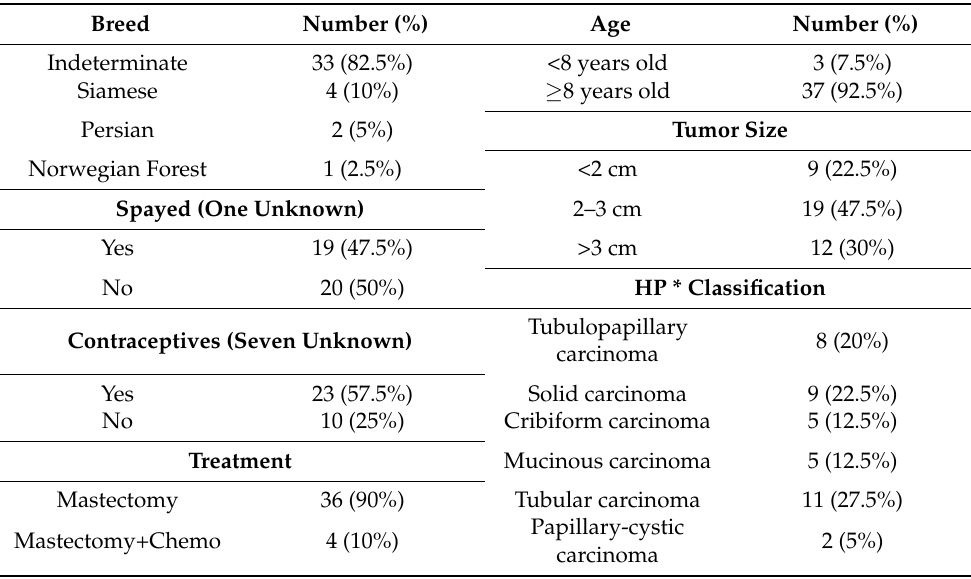
Table 4. Clinicopathological features of female cats with mammary carcinomas enrolled in this study (n =